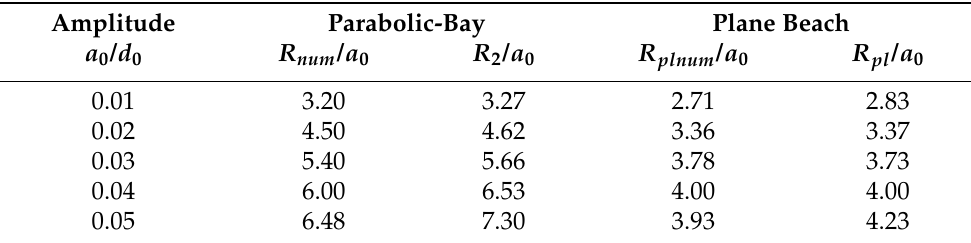
Figure 8. ( a ) Free surface motion in the simulation of a solitary wave run up; and ( b ) shoreline dynamics as a function of time, resulting from the run up of a solitary wave (19) for a narrow bays with m = 2. Table 1. Run-up height of solitary wave in the parabolic bay B ∗ between numeric and